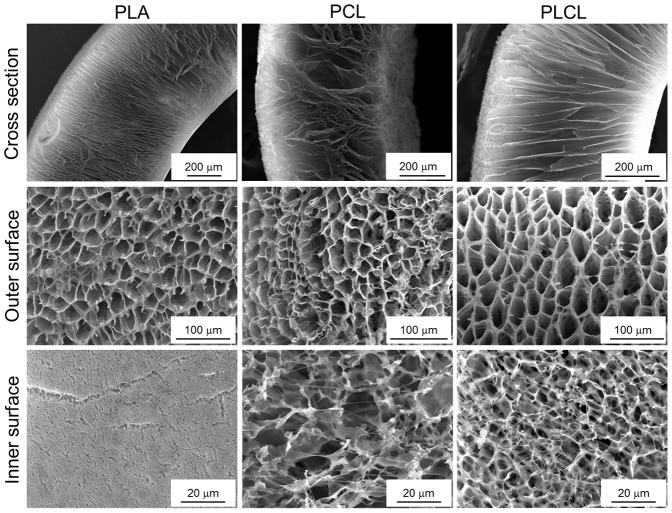
Influence of the polymer type.SEM images of the cross section, the outer and inner surfaces of the foams prepared from PLA, PCL and PLCL300 (5% w/v, quenched at −80°C for 30 s) revealed the relatively superior pore morphology without any micro-cracks of the PLCL foam as compared to that of pure PLA and PCL foams.